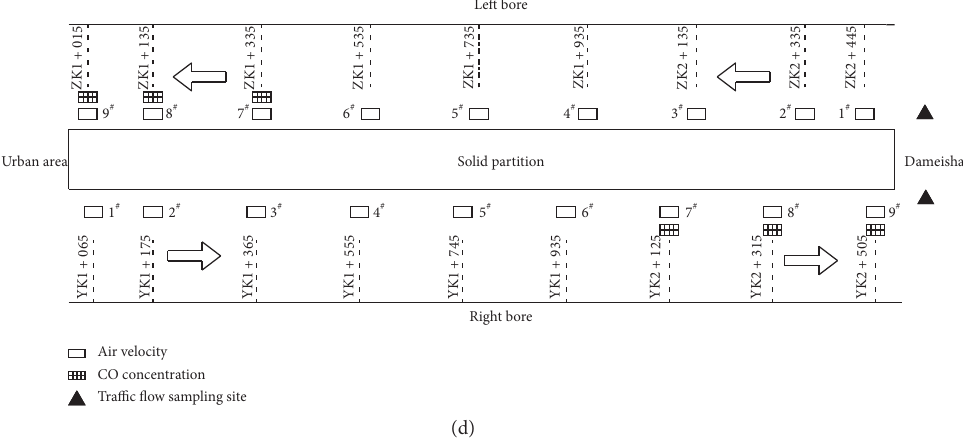
Figure 4: The sampling points distribution in the four urban tunnels. (a) Henglong Mountain Tunnel. (b) Cejiexian Subway. (c) Jiuweiling Tunnel. (d) Dameisha